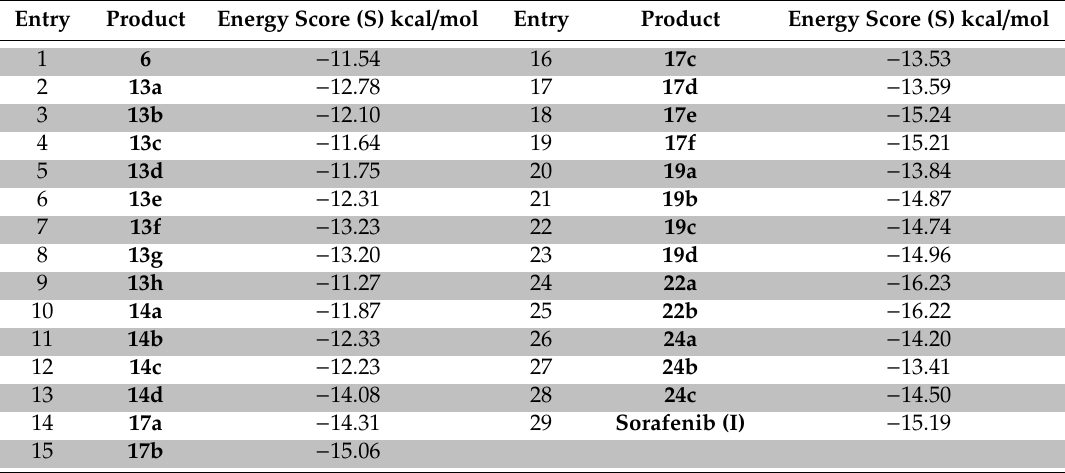
Table 6. Docking energy scores (S) in kcal / mol for the newly synthesized compounds and the reference compound (sorafenib I ) in the VEGFR-2 active site.